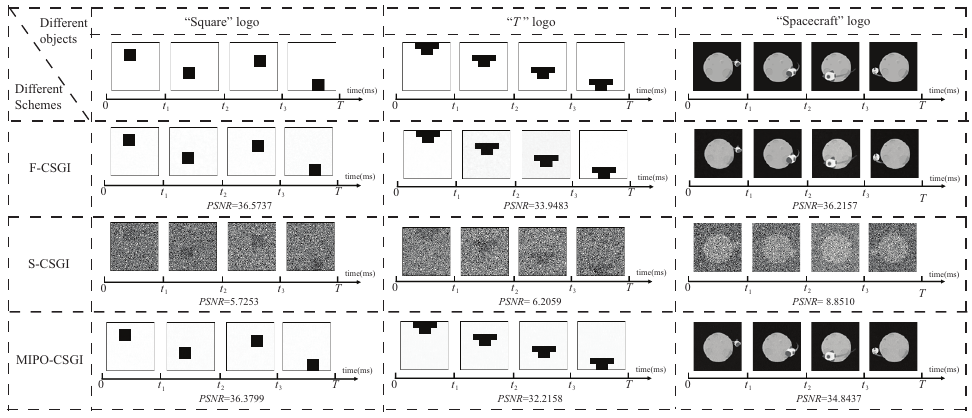
Figure 2. The numerical simulation results of different periodic moving objects using F-CSGI, S-CSGI, and MIPO-CSGI, where PSNR is presented together.